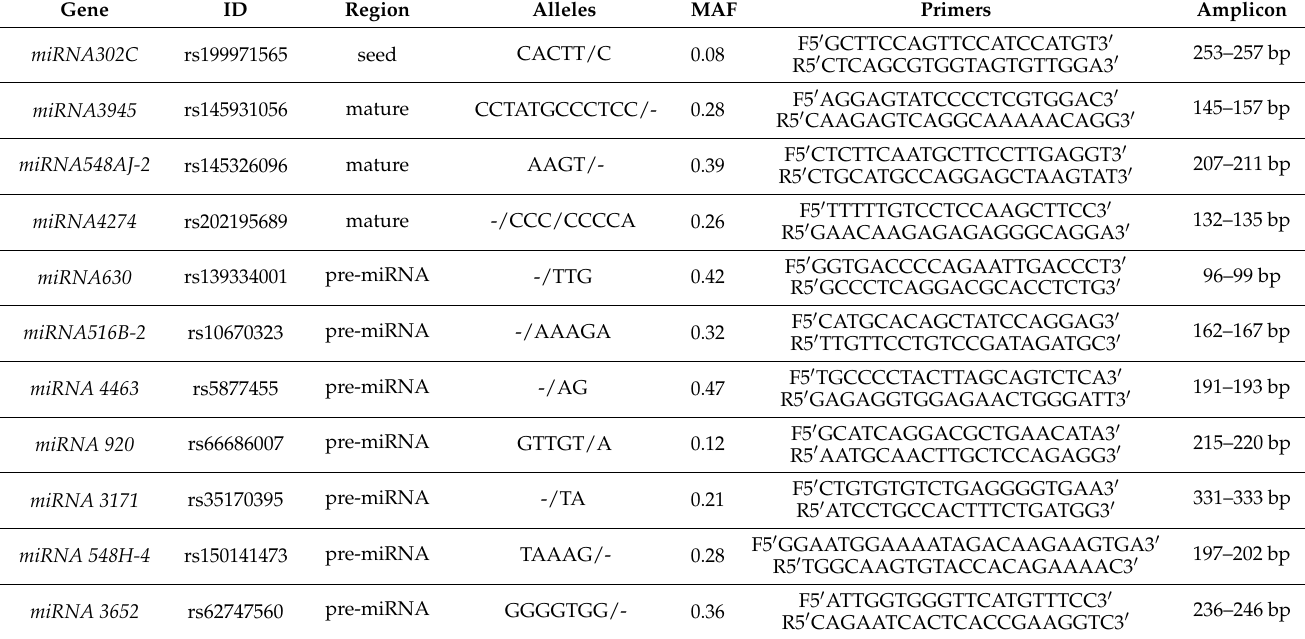
Table 1. Technical characteristics of the markers selected in this